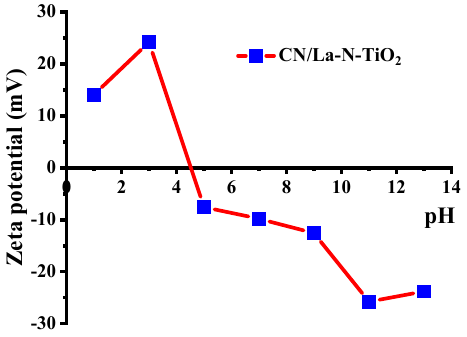
Figure 8. Zeta potential of CN/La-N-TiO 2 in different pH conditions.